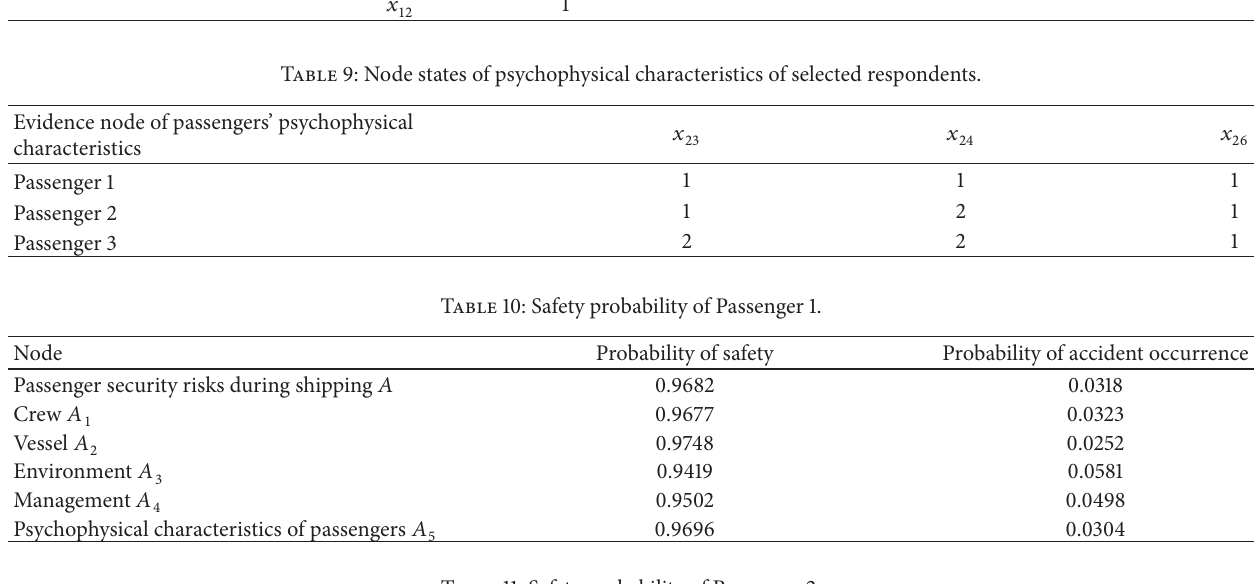
Table 11: Safety probability of Passenger 2.